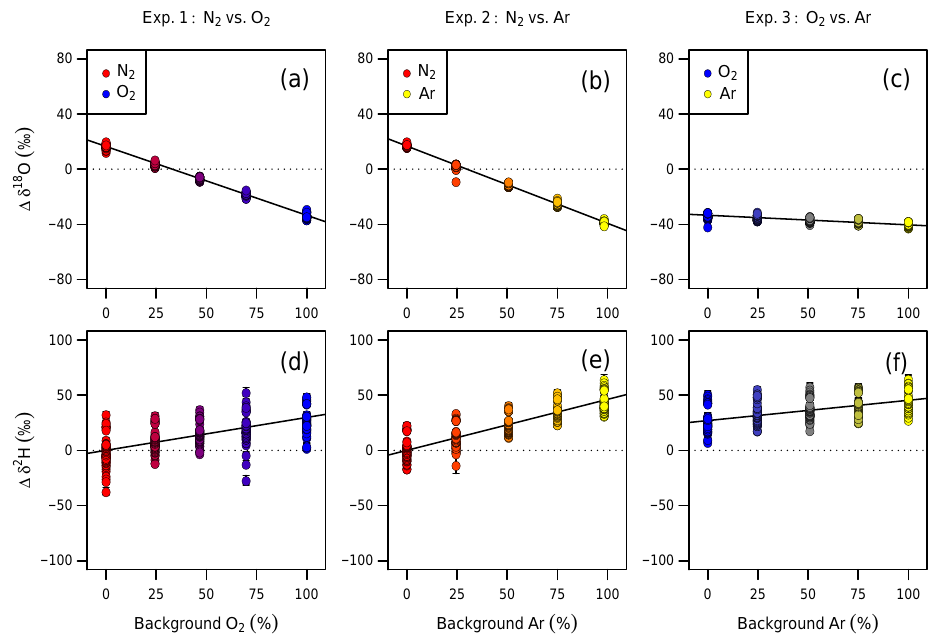
Figure 2. Sensitivity of δ 18 O and δ 2 H values to background N 2 , O 2 , and Ar mixing ratios. For each experiment, sensitivity is plotted as the difference between the apparent and true isotopic composition of the standards (i.e., (cid:49)δ 18 O = δ 18 O apparent − δ 18 O true and (cid:49)δ 2 H = δ 2 H apparent – δ 2 H true ) . For each panel, n = 330 measurements of four liquid standards across a range of injection volumes (i.e., 400– 2400nL, in 11 steps of 200nL each). Points represent mean values ± SD for replicates of each standard at each injection volume, and regression slopes are given by β 5 values in Table